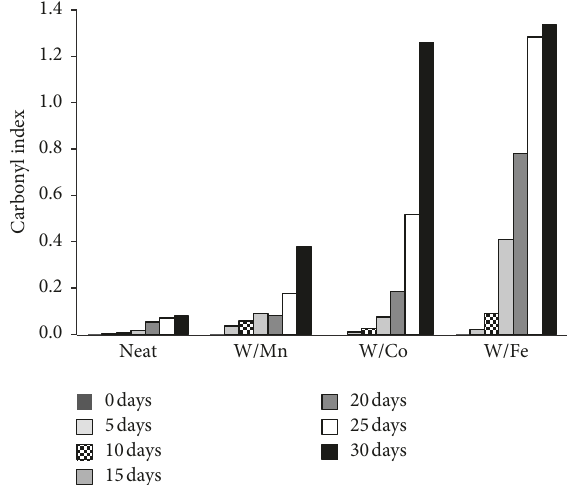
Figure 6: Increase in the carbonyl index of Topas 8007 COC neat and formulated films during exposure to QUV